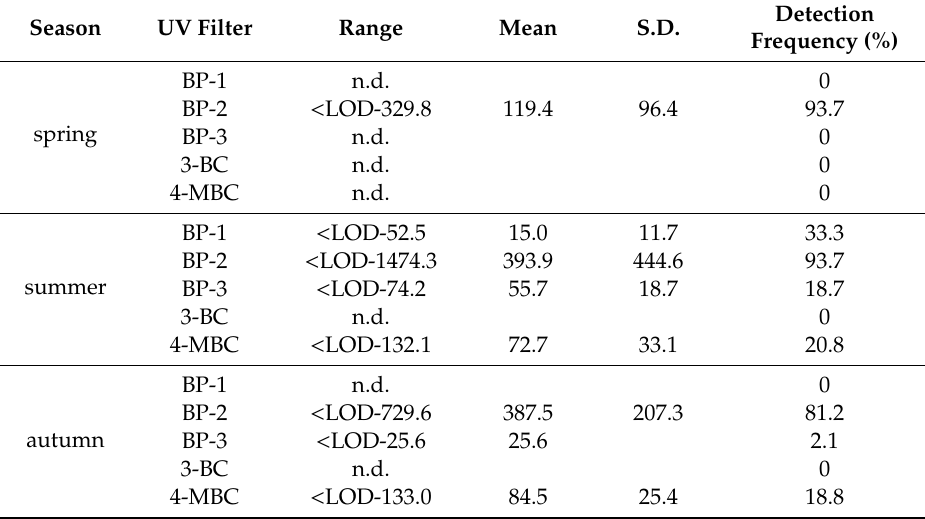
Table 4. Concentration range (ng · kg − 1 d.w.), mean concentrations (ng · kg − 1 d.w.), and detection frequencies (%) of UV filters in core sediments collected in spring, summer, and autumn, 2017 (n.d.—not